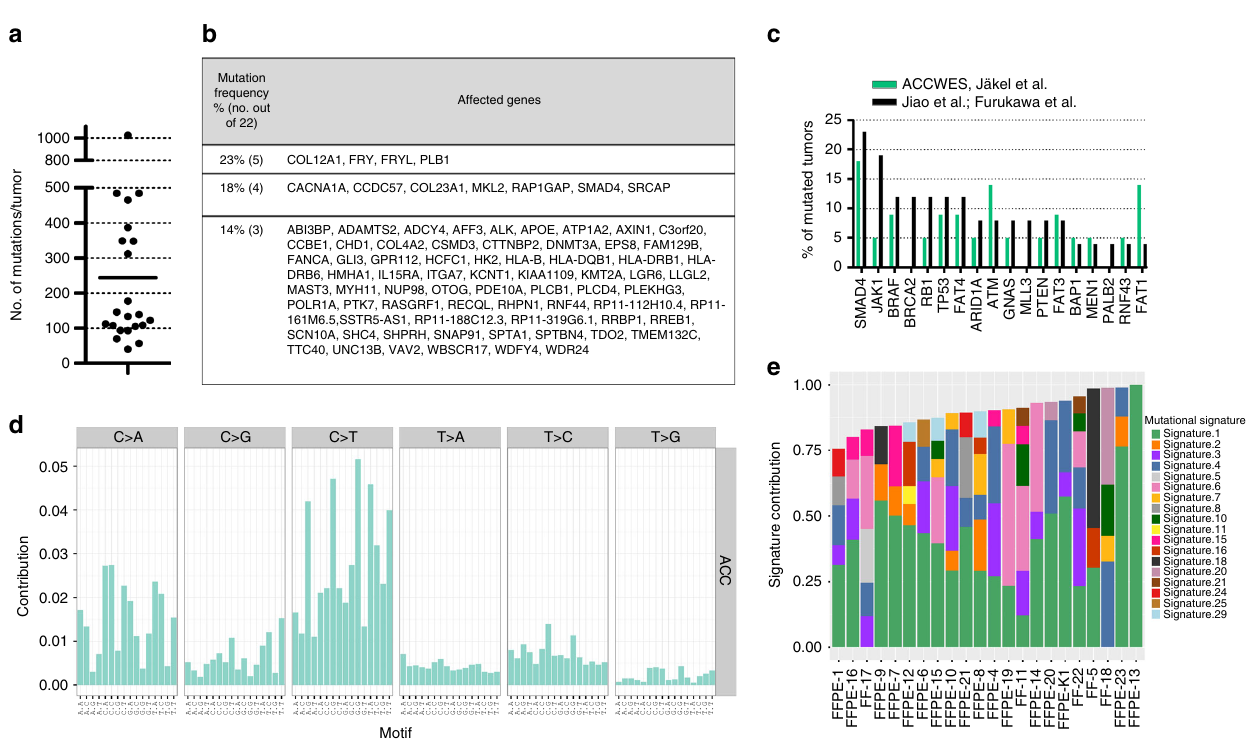
Fig. 1 ACC display a high-mutational load and speci fi c mutational signatures. a Number of mutated genes per tumor detected by WES. b Genes with most recurrent, however, still low frequency point mutations in ACC. c Comparison of WES results to published studies 12, 13 of ACC shows a similar low frequency of recurrent mutations. Both published studies 12, 13 were utilized as a comparison in combination as one of them only contained three ACC. d Mutational pattern of ACC. The type of base substitution in their genomic context (base preceding and base following) is displayed. e Published mutational signatures 27 present in each sample is displayed. Associations of signatures: signature 1: deamination of 5-methylcytosine, signature 4: